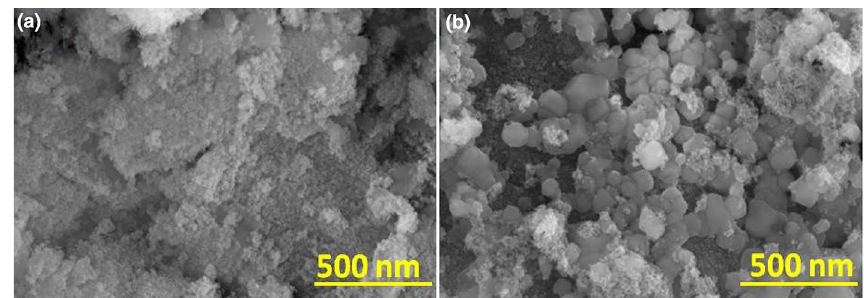
Figure 2. SEM analysis of ( a ) NiO and ( b ) Mo doped NiO NPs.